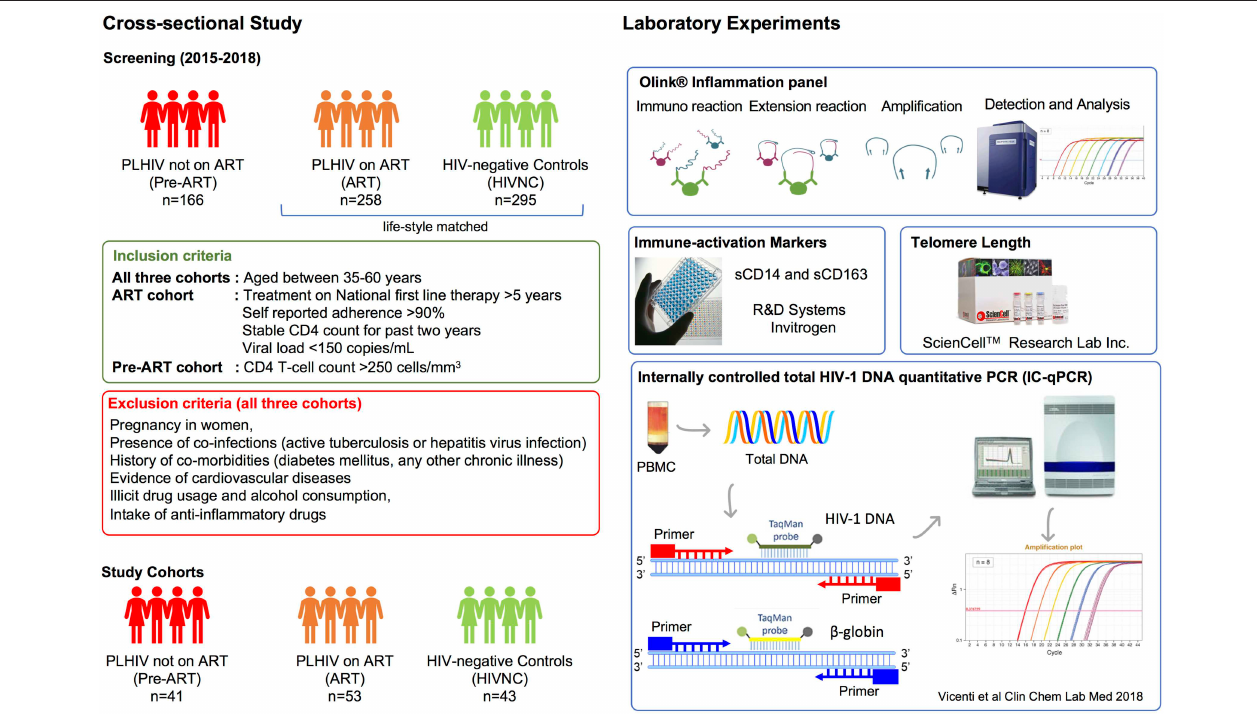
FIGURE 1 | Flow diagram of study design and experimental plan. 424 HIV-1 positive individuals and 295 HIV-1 negative healthy controls were screened. Following defined inclusion and exclusion criteria, 43 healthy controls, and 53 HIV positive ART-experienced subjects and 41 ART-naïve HIV-1 positive subjects were recruited for the study. The methodology used for the study is also